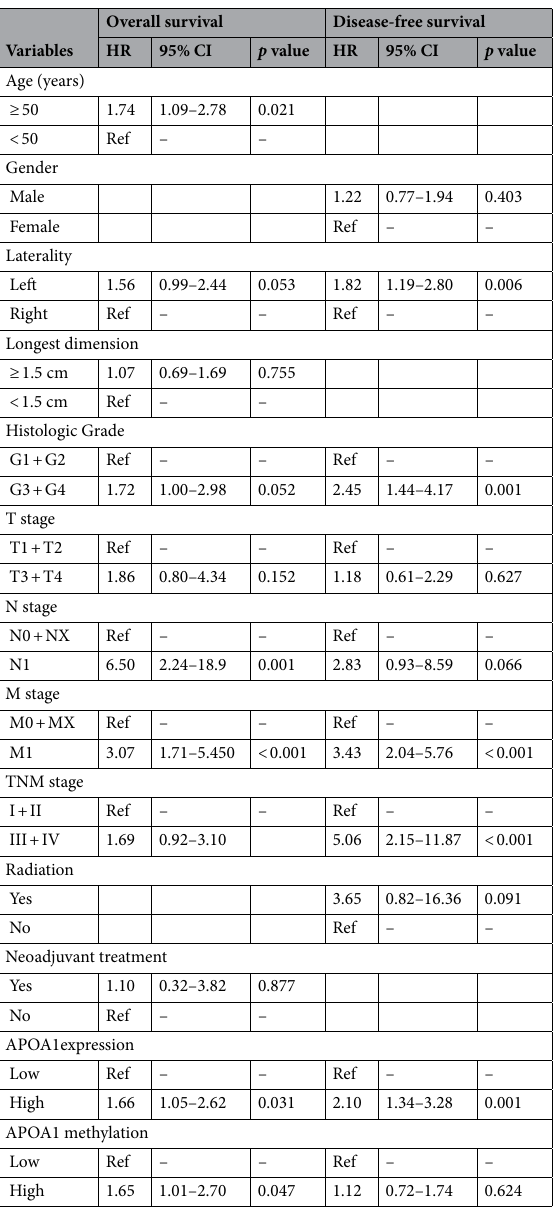
Table 1. Multivariable analysis of APOA1 mRNA expression/methylation for overall survival/disease-free